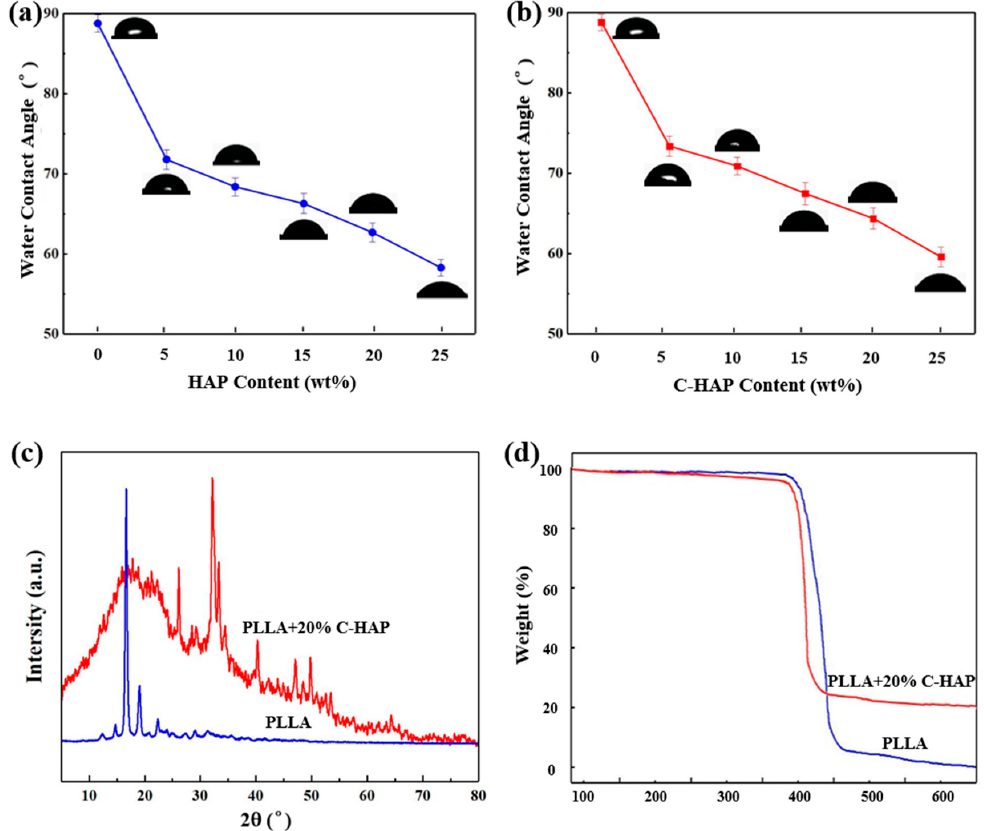
Figure 6. Water contact analysis (WCA) of PLLA sca ff olds with di ff erent contents of ( a ) HAP, ( b ) C-HAP, ( c ) XRD pattern of PLLA / 20% C-HAP and PLLA sca ff olds, ( d ) TGA analysis of PLLA / 20% C-HAP and PLLA sca ff